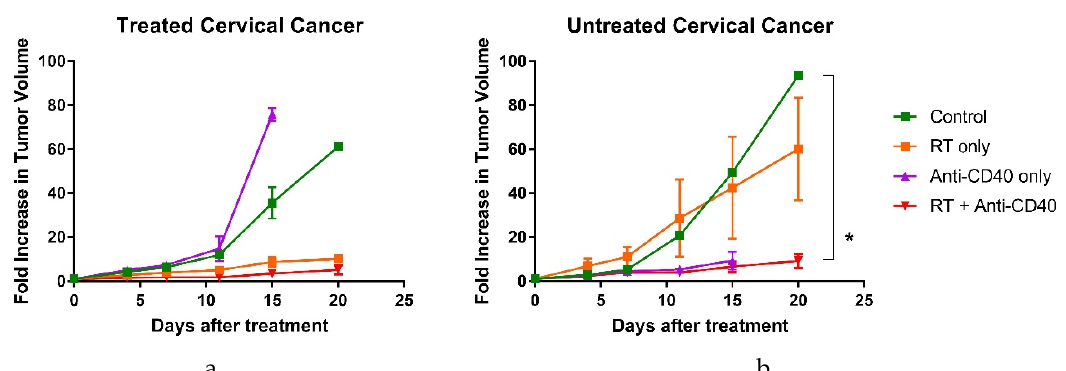
Figure 2. Investigating the abscopal effect in cervical cancer mouse model represented by tumor volume (mean ± SEM) in ( a ) treated and ( b ) untreated groups ( n = 5). The abscopal effect was observed in combination treatment group with a significant tumor growth control in untreated and treated tumors. * p < 0.05.